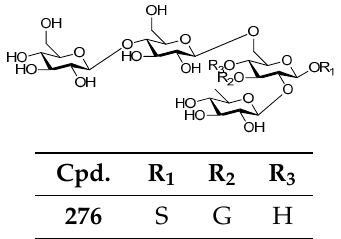
Figure 59. Structure of compound 276 .